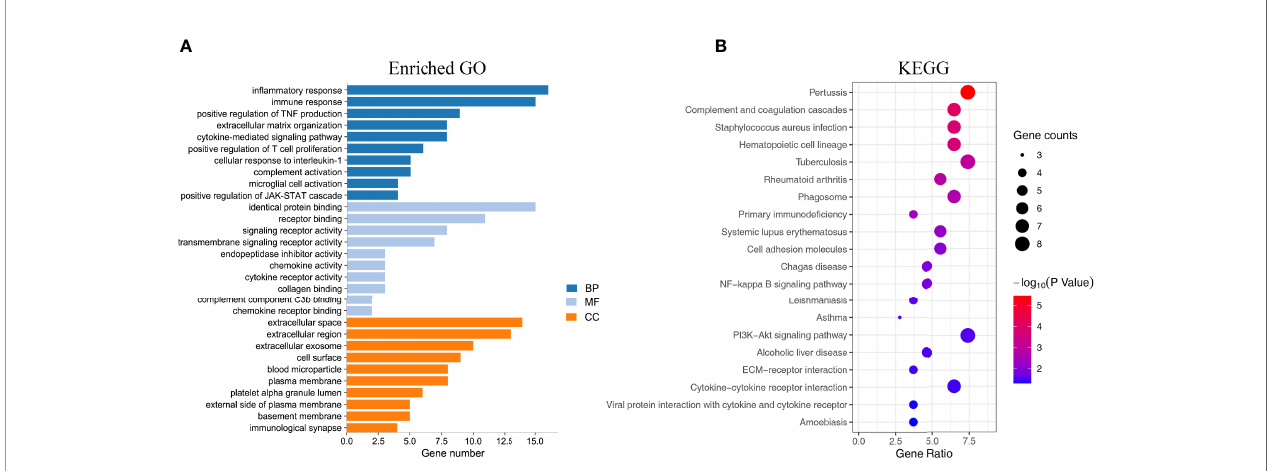
FIGURE 3 | Enrichment analysis of the DEGs. (A) The top 10 enriched GO analysis results. (B) The top 20 KEGG pathways results. The size of the spots indicates the number of genes, and the color indicates the